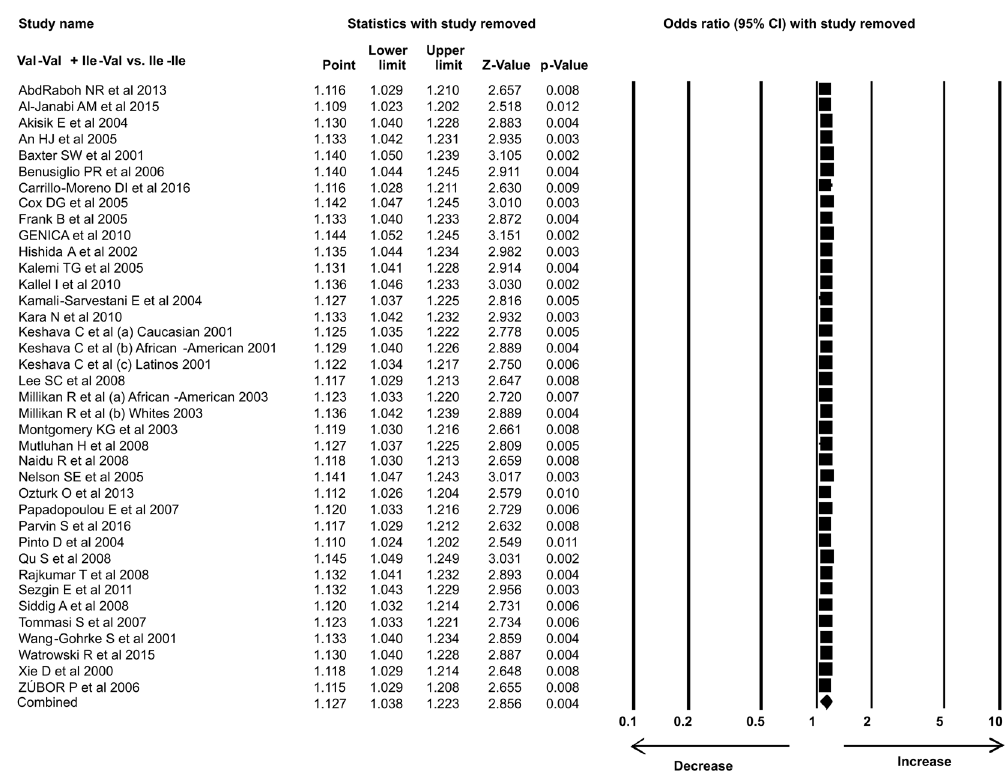
Figure 15. Sensitivity analysis: Sensitivity analysis showing no effect of single study on OR of genotypic (Dominant: Val-Val + Ile-Val vs Ile-Ile) analysis model of Her2 Ile 655 Val (rs1136201) gene